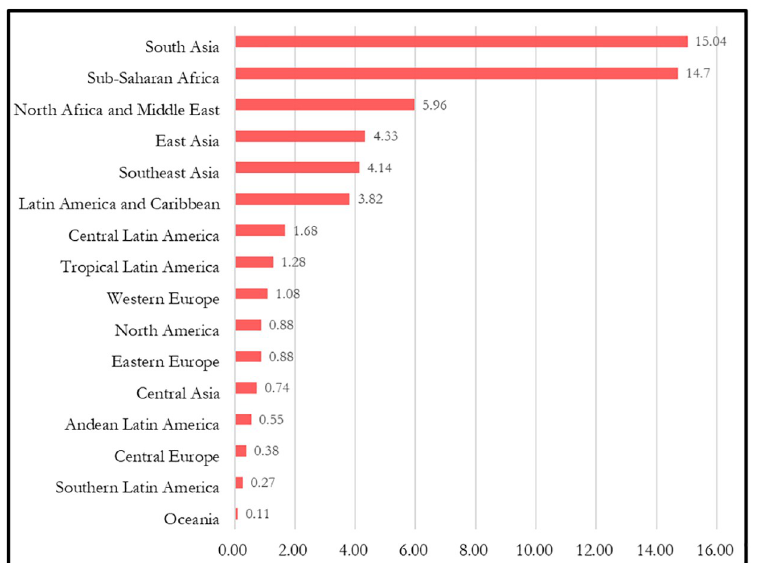
Fig 1. Prevalence (cases) of under-five developmental disability by region. (Source: [1]).